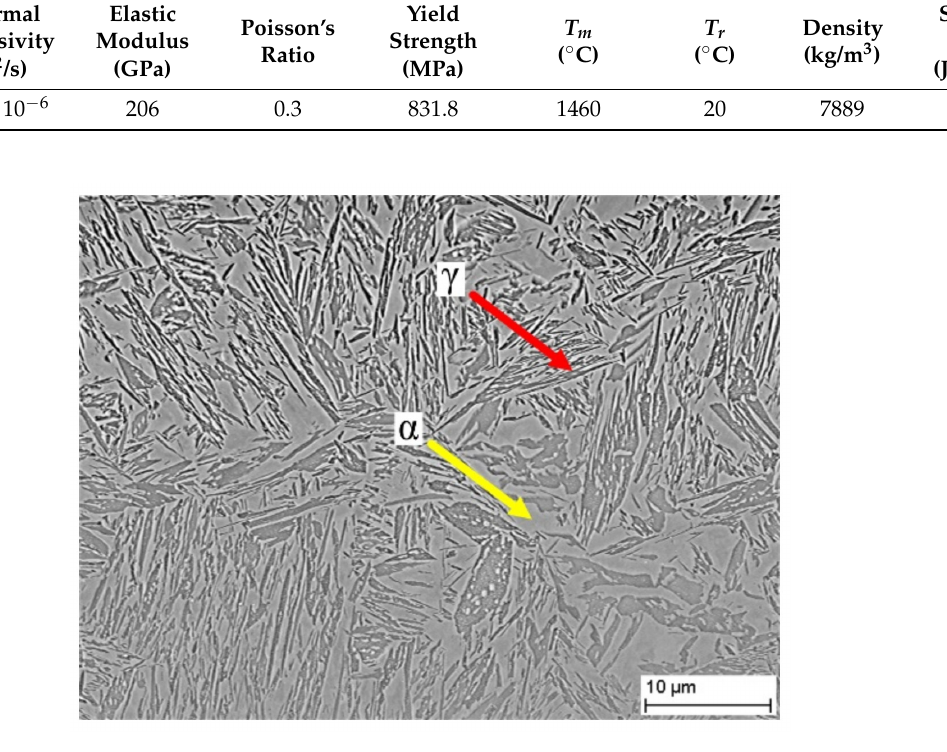
Figure 6. Initial microstructure of AerMet100